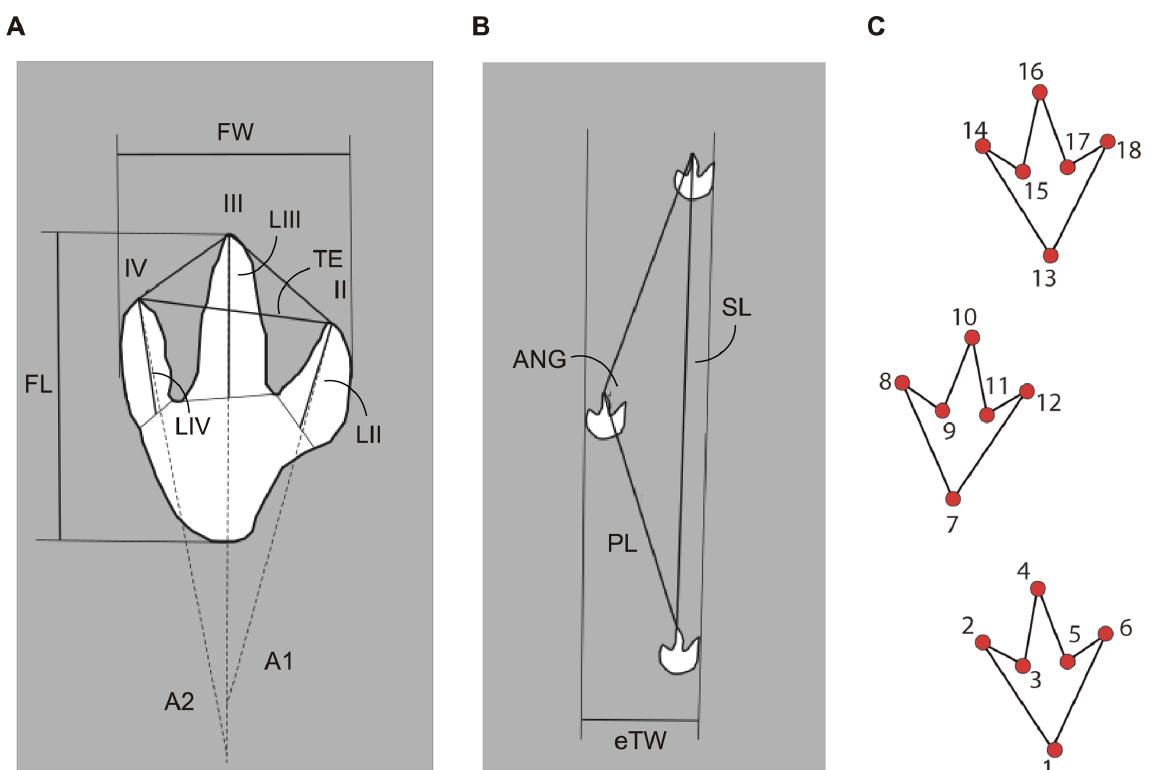
Fig 2. Metrics used. (A) Footprint measurements. (B) Trackway measurements. (C) Set of landmark used in geometric morphometrics. Abbreviations: ANG, pace angle; A1, angle between digits II and III; A2, angle between digits III and IV; eTW, external trackway width; FL, footprint length; FW, footprint width; LII-IV, length of digits; PL, pace length; SL, stride length; TE, toe